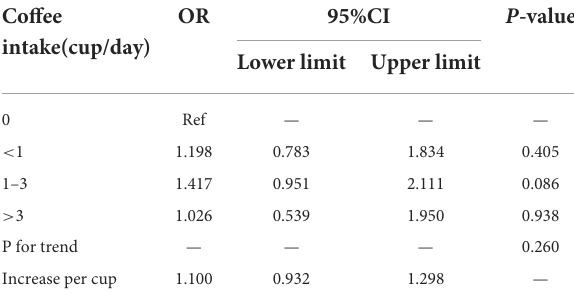
TABLE 2 Weighted multivariable-adjusted a logistic regression of RA risk across coffee intake categories in NHANES